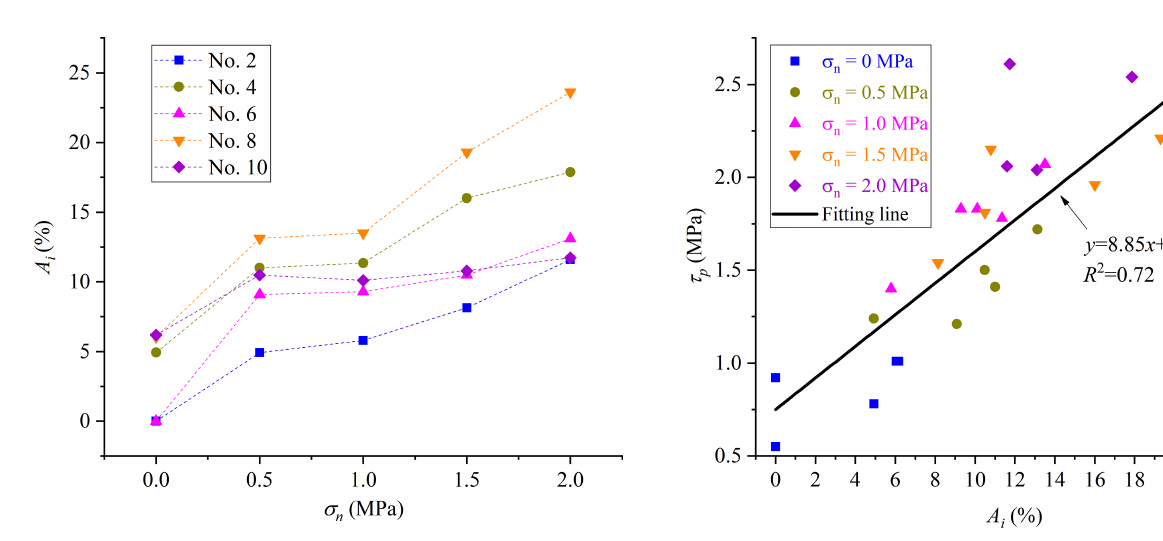
Figure 20. Peak shear strength linearly increases with increas- ing aggregation areas of rupture ice. Experimental